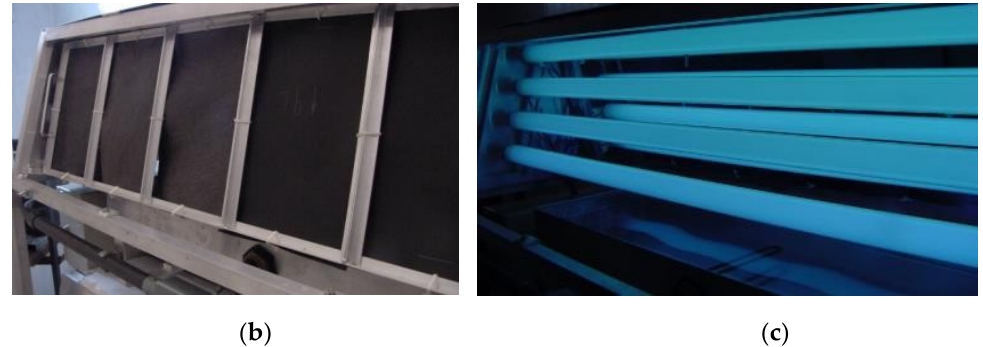
Figure 1. UV weathering chamber: ( a ) schematic of a condensation cycle, ( b ) test sample arrangement, and ( c ) UV lamp detail.